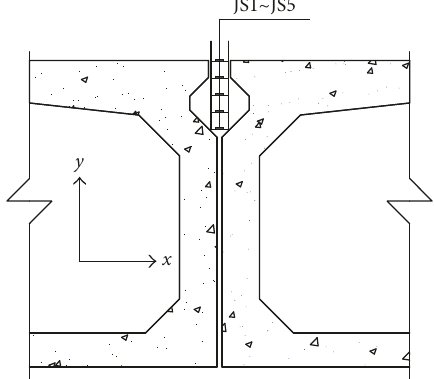
Figure 8: Strain measurement points for the hollow slab.